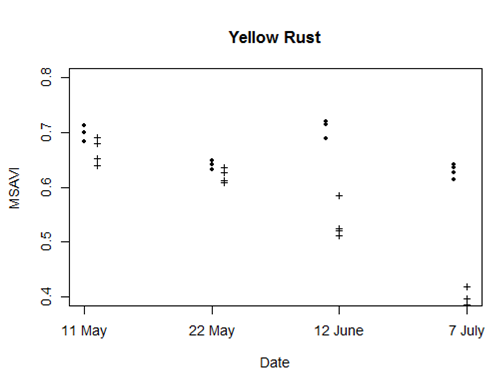
Figure 7. MSAVI (Modified Soil Adjusted Vegetation Index) of yellow rust-infected plots. Dots are plots without fungicides treatment, crosses are plots with fungicides